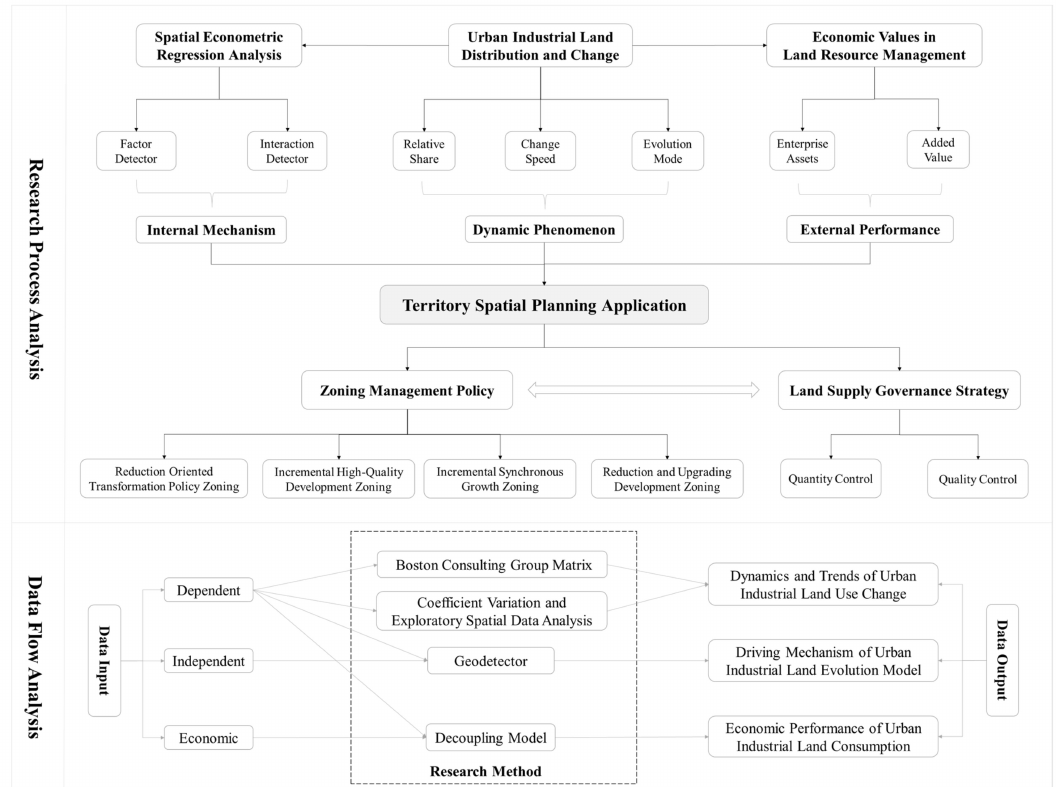
Figure 2. Research steps and technical